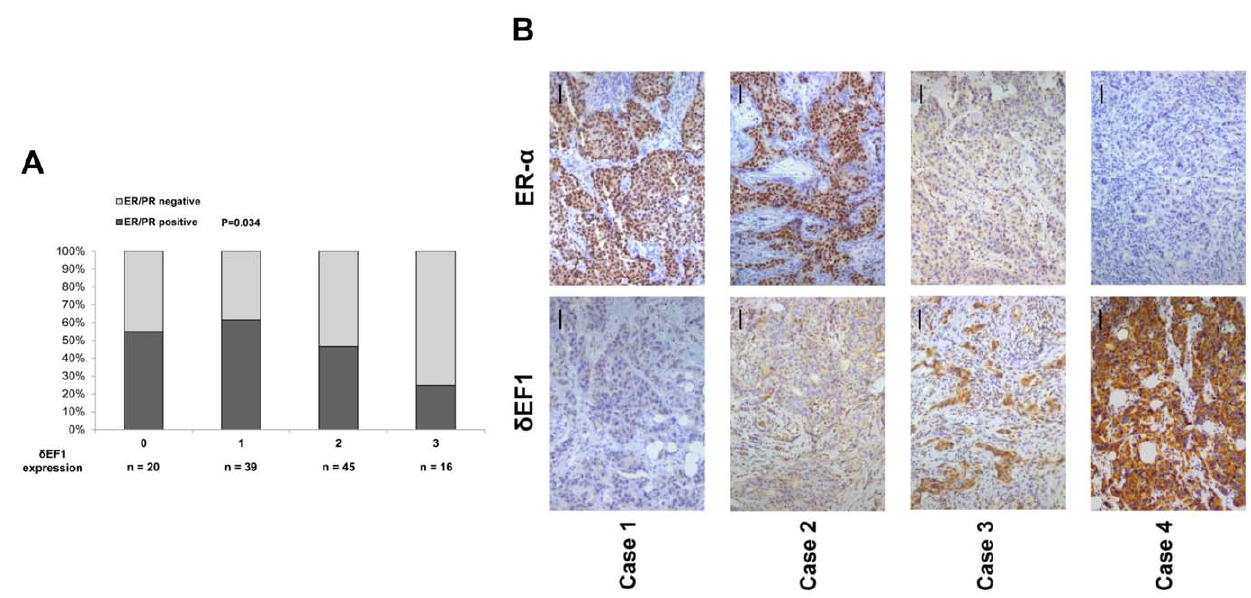
Figure 5. Expression of d EF1 and ER- a is inversely correlated in breast cancer specimens. A. The positive percentage analysis for ER- a indicates a negative correlation with d EF1 expression in breast cancer tumors from 120 subjects. B. Representative images of immunohistochemical staining of d EF1 and ER- a in two serial sections of the same tumor from four cases are shown. Scale bars, 50 m m.